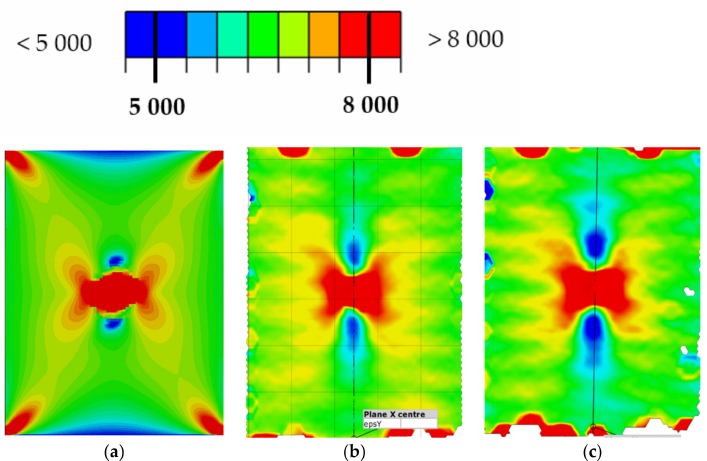
Figure 15. Max. principal strain distribution ( µ m/m) at load 80 kN; ( a ) Simulation; ( b ) Experiment sample 1; ( c ) Experiment sample 2.